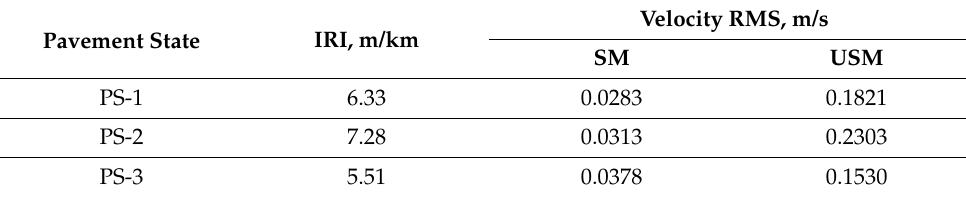
Table 1. The estimated IRI values of the analysed gravel pavement. Pavement